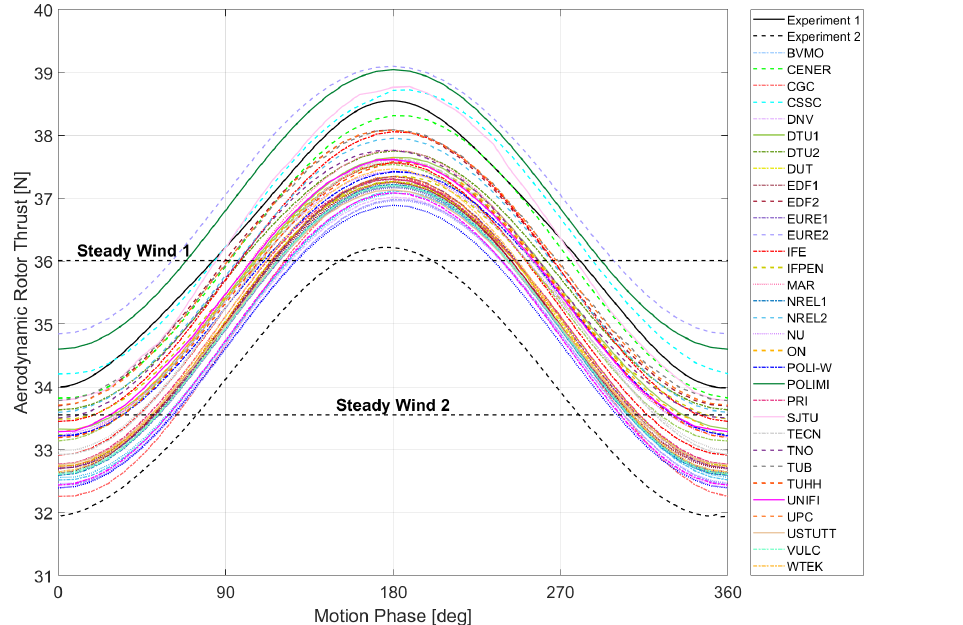
Figure 13. Aerodynamic rotor thrust variation during one surge period in Load Case 2.5. Results from the experiments and participants. Pattern: BEM (:), DBEM (-.), GDW (-.), FVW (- -), and CFD